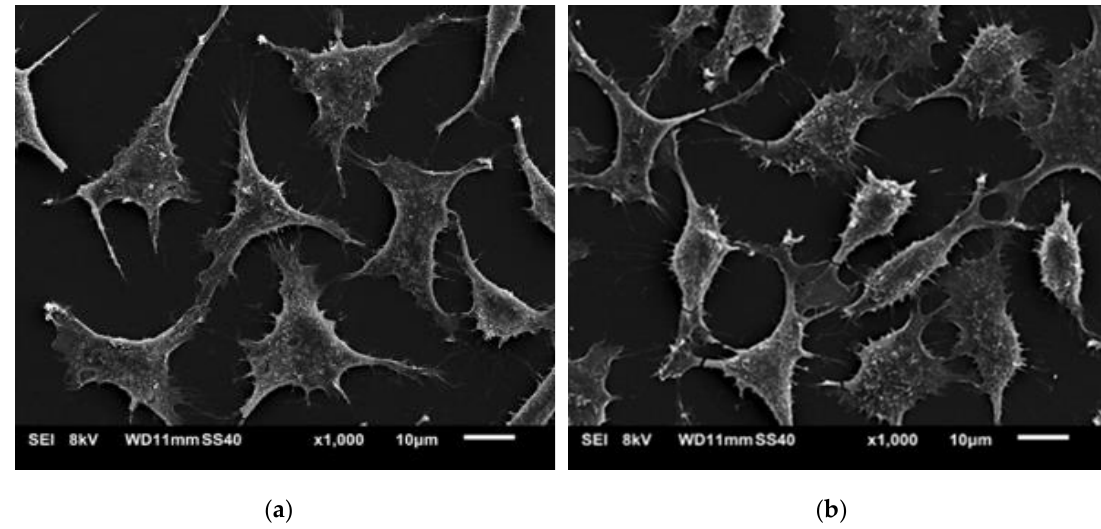
Figure 11. SEM of L929 cells on ( a ) tissue culture plastic (TCP) (control) and ( b ) hydrogel containing 1 wt.% of MC (50 µl volume).